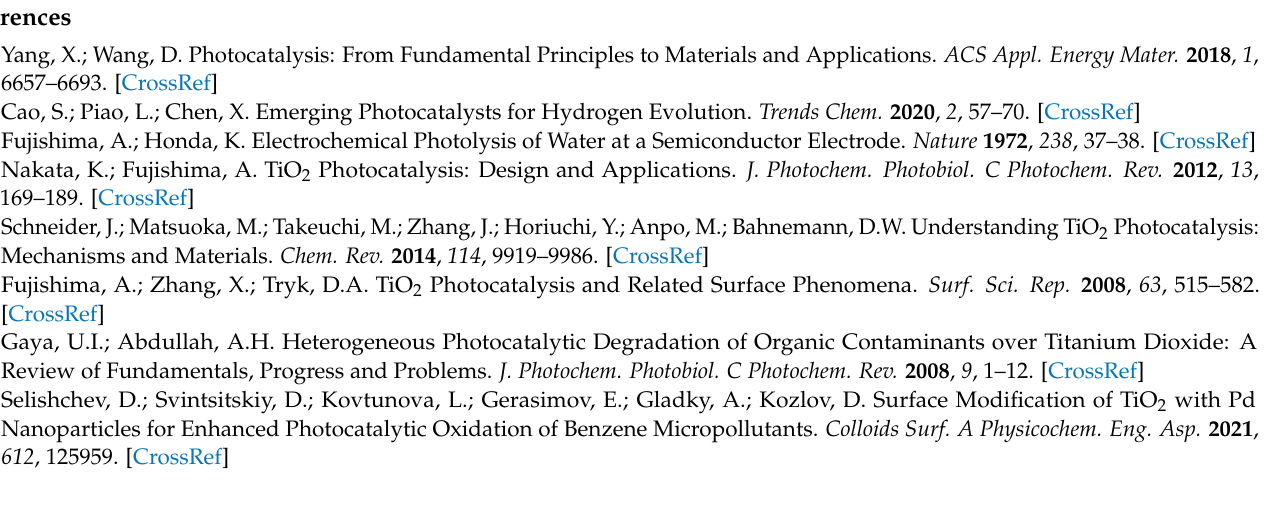
TiO 2 -N samples calcined at different temperatures in reflectance (a) and Kubelka-Munk (b) modes; Figure S5: effect of Fe content on the visible-light activity of Fe/TiO 2 -N; Figure S6: photoelectron Fe2p spectral region for 0.3% Fe/TiO 2 -N sample; Table S1: average crystallite sizes (D), strain values ( ε ), lattice constants (a and c), volumes of unit cell (V) for TiO 2 and TiO 2 -N samples calcined at different temperatures; Table S2: visible-light activity of TiO 2 -N toward Aeroxide P25. References [91–109] are cited in the supplementary